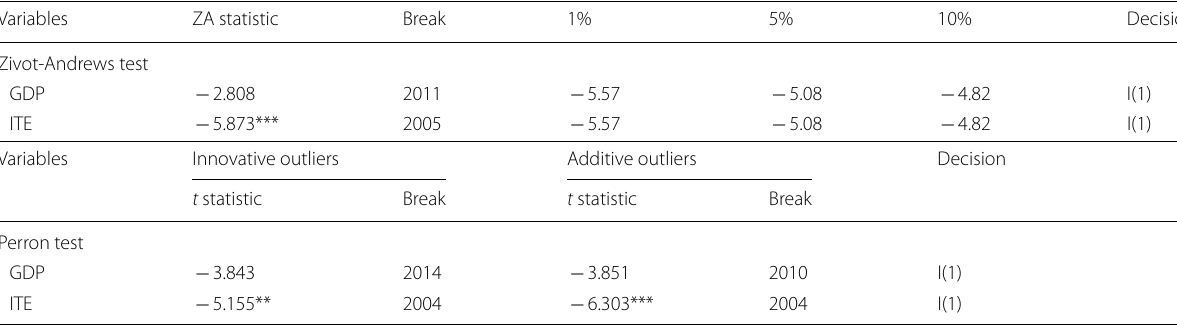
Table 4 Unit root test with structural